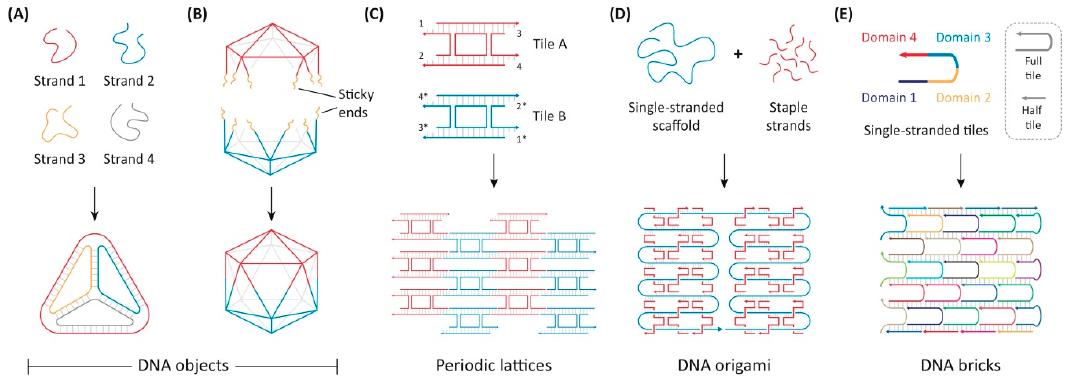
Figure 2. Structural DNA nanotechnology approaches for drug delivery. Common methods for creating DNA nanostructures include ( A , B ) junction and lattice-based structures like DNA nanocages, ( C ) periodic lattices, ( D ) scaffolded DNA origami and ( E ) scaffold-free assembly of single-stranded tiles (SSTs), otherwise known as DNA “DNA bricks”. Panels (A through E) reprinted with permission